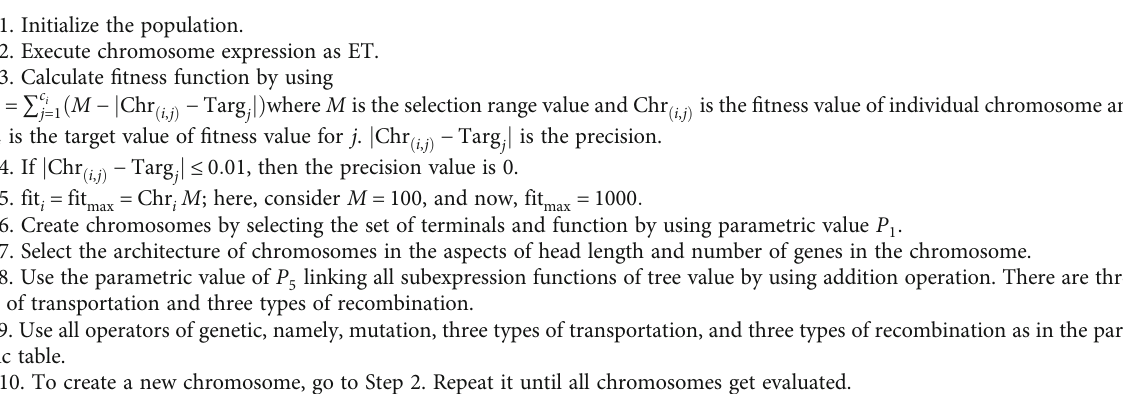
Algorithm 1: GEP for biomass wastage.